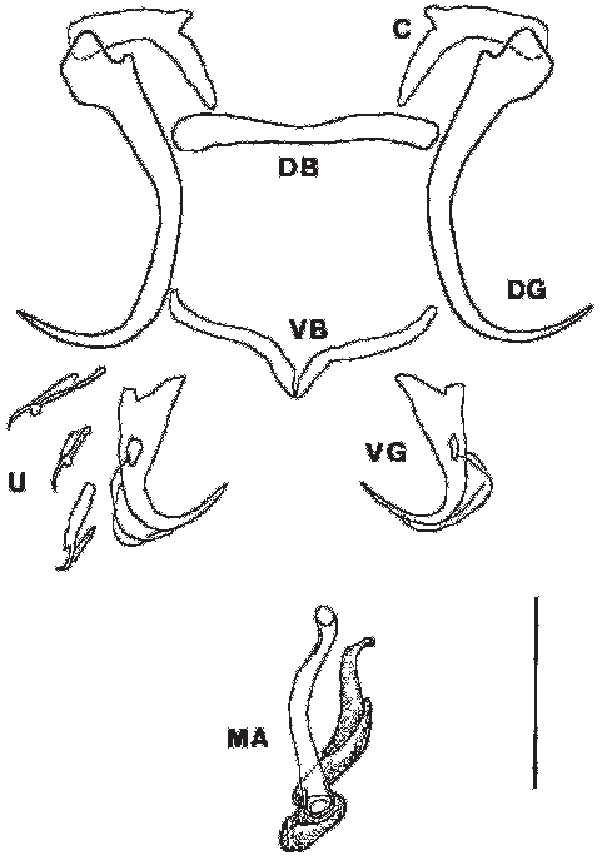
Fig. 3. – Thaparocleidus teugelsi n. sp. C = cuneus; DB = dorsal trans- verse bar; DG = dorsal gripus; MA = male apparatus; VB = ventral transverse bar; VG = ventral gripus; U = uncinuli. Bar = 30